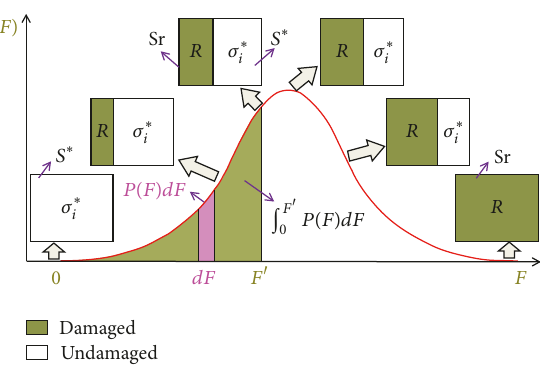
Figure 3: Weibull distribution and damage transition processes. Theserectanglesrepresentrockswithdifferentdegreesofdamage. 𝑆 ∗ represents the undamaged area and the force of the undamaged area is determined by the net stress ( 𝜎 ∗ ) of undamaged portion, while for damaged portion (Sr), a residual strength ( 𝑅 ) is applied (modified from Zhao et al.